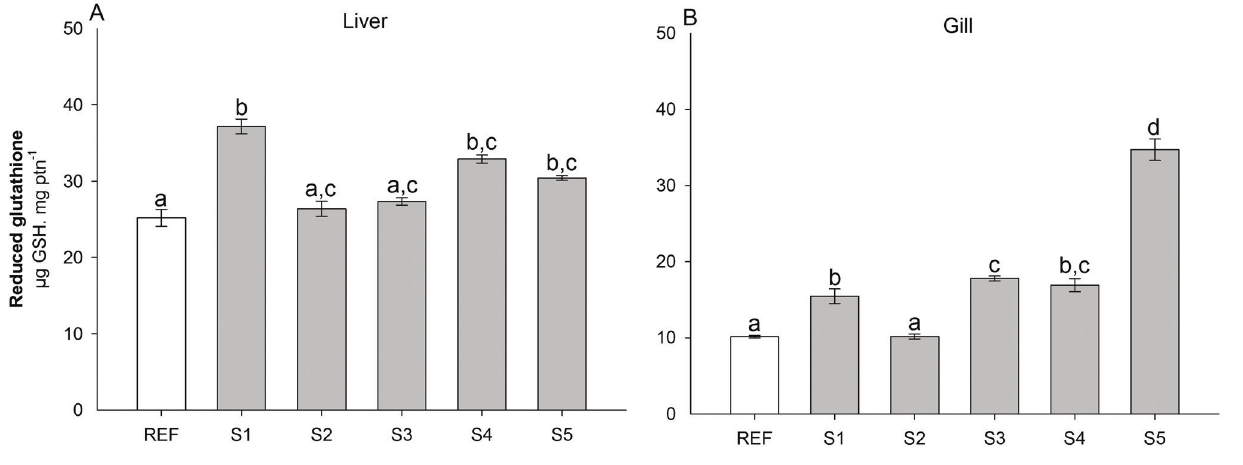
Fig. 4. Content (mean ± SEM, n = 8) of glutathione in liver (A) and gills (B) of A. altiparanae exposed in situ for seven days in five sites along Água das Araras stream (S1, S2, S3, S4, and S5) and in a reference site (Ref). Different letters indicate significant differences between sites (P<0.05).